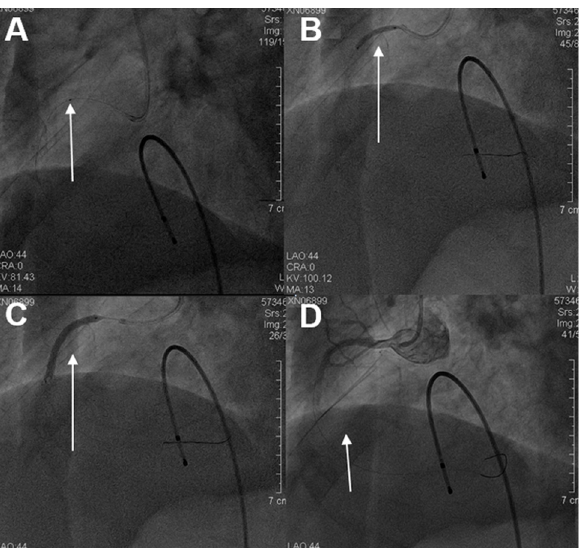
Fig 2. PCI intervention therapy of the same patient in Fig 1. Coronary thrombus aspiration was shown (arrow, Fig 2A), balloon dilatation (arrow, Fig 2B), stent implantation (arrow, Fig 2C), and no-reflow imaging (arrow, Fig 2D).